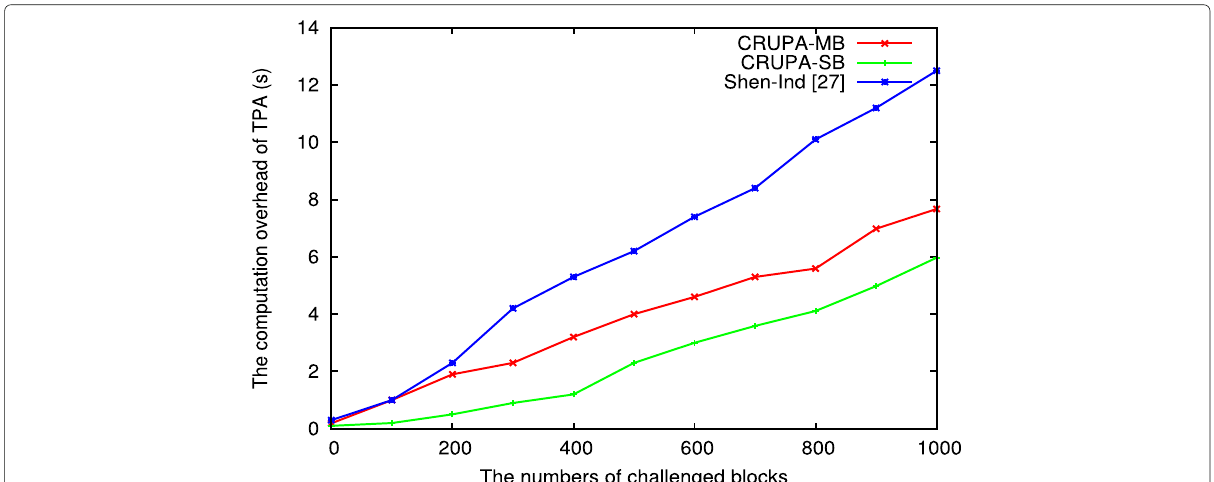
Fig. 7 Computation overhead of TPA during proof